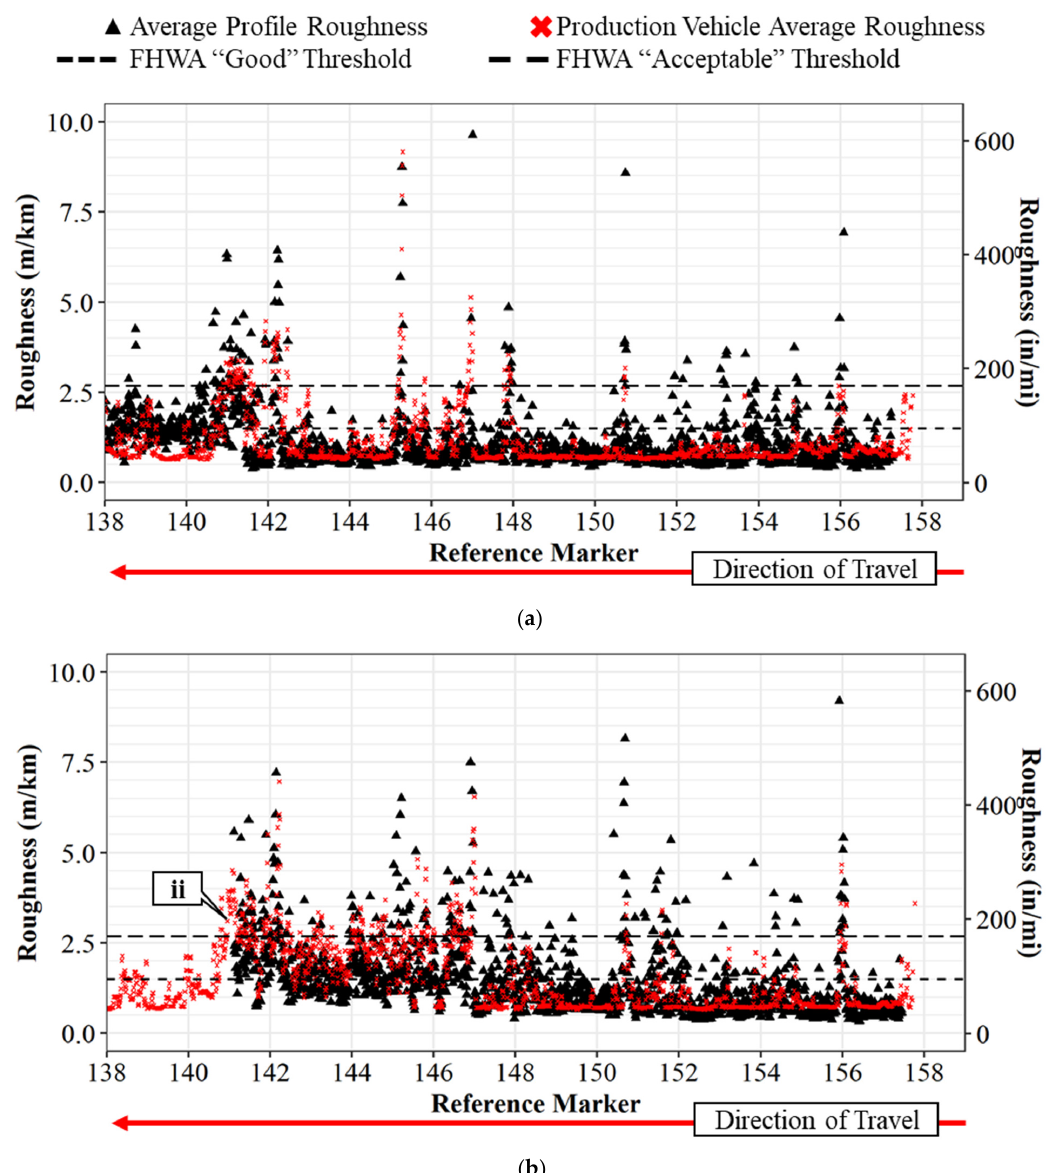
Figure 5. IRI comparison between inertial profiler and single production vehicle for I-65 north- bound: ( a ) left lane; ( b ) right lane. Callout (i) data collection discontinued due to congestion.